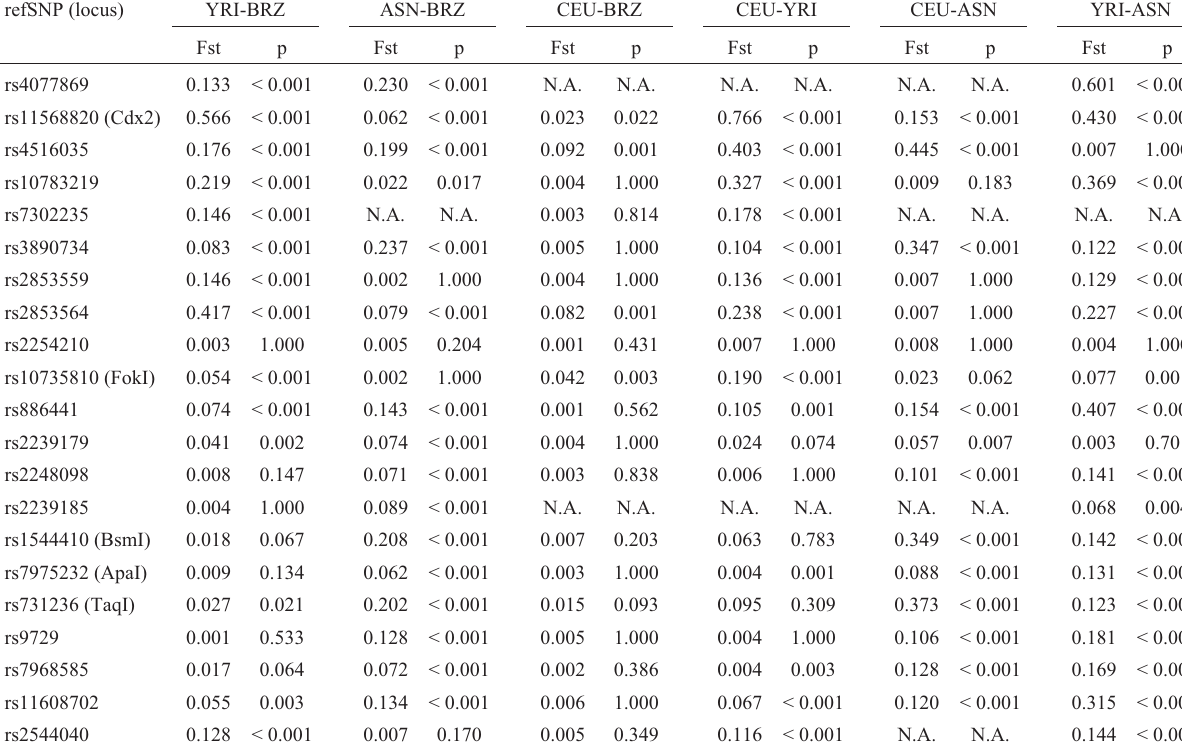
Table 2 - Pairwise population differences (Fst) for locus-by-locus analysis for the HapMap samples and total Brazilian population. refSNP (locus)